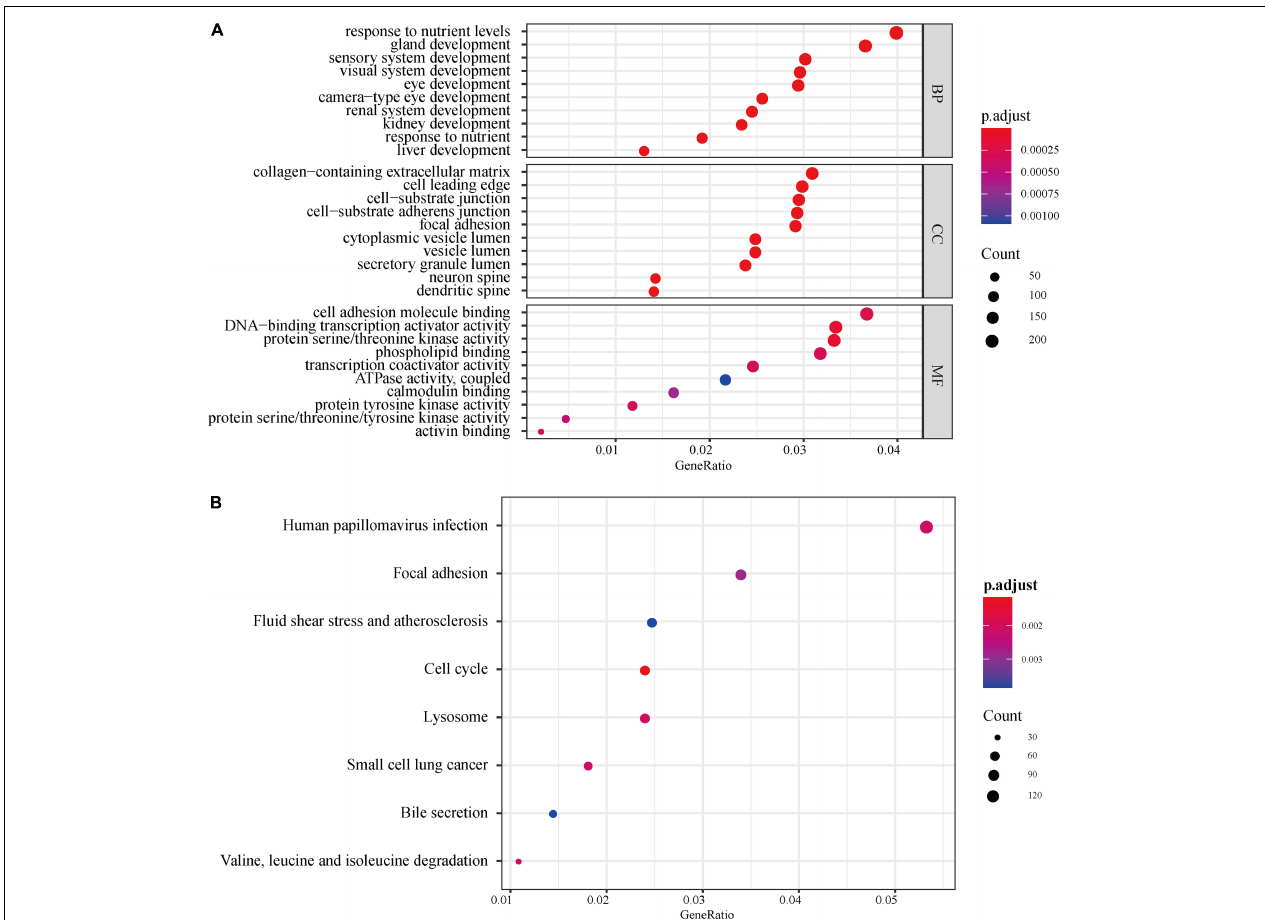
FIGURE 2 | GO and KEGG pathway enrichment analyses of autophagy-related lncRNAs. (A) GO analysis results. The color of the dots represents the adjusted P -value: red, low; blue, high. The size of the dots represents the number of autophagy-related genes. (B) KEGG pathway enrichment analyses. The color of the dots represents the adjusted P -value, and the size of the dots represents the number of autophagy-related genes in the pathway. GO, gene ontology; KEGG, Kyoto Encyclopedia of Genes and Genomes; p.adjust, adjusted P -value; BP, biological process; CC, cellular component; MF, molecular function.